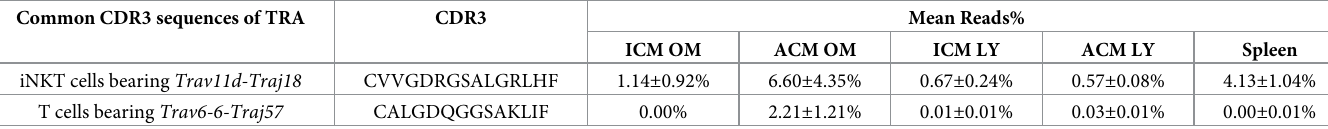
Table 1. Distributions of read % of iNKT cells and T cells bearing Trav6-6-Traj57 in ICM, ACM mice and normal spleen. Common CDR3 sequences of TRA CDR3 iNKT cells bearing Trav11d-Traj18 T cells bearing Trav6-6-Traj57 Amino acid sequences of CDR3 regions of TRA were obtained from the oral mucosa and cervical lymph nodes of ACM and ICM mice. Spleens were obtained from normal BALB/cAJcl mice. The proportion of iNKT cells and T cells bearing Trav6-6-Traj57 were calculated from the total number of detected TRA clones. The proportion of iNKT cells in the oral mucosa of ACM mice was higher than in the oral mucosa of ICM mice and normal spleens. T cells bearing Trav6-6-Traj57 were detected in the oral mucosa and cervical lymph nodes of ACM mice, but rarely detected in ICM mice or normal spleens. OM; oral mucosa, LY; cervical lymph